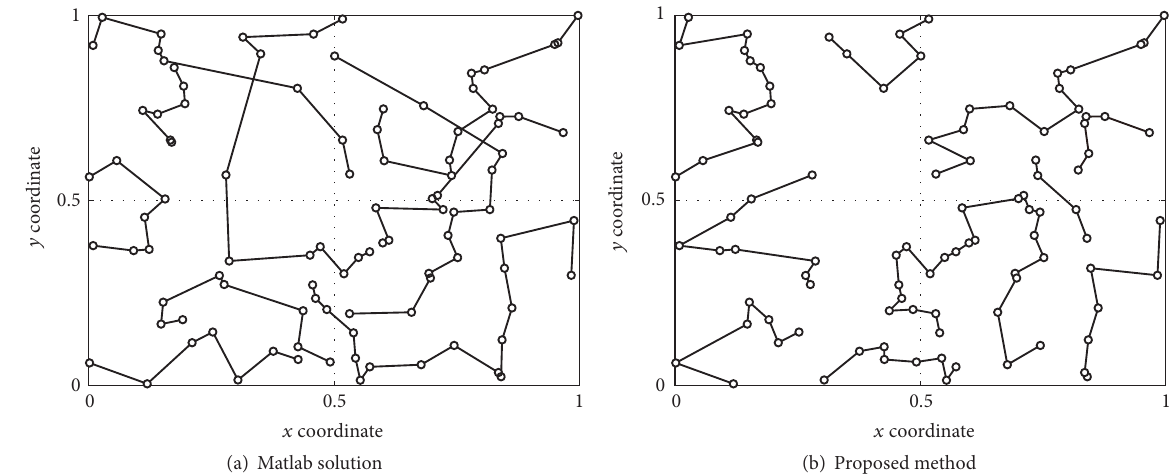
Figure 8: GAID has been compared with the Matlab MTSP solver. In this example, MAPP is solved for 100 targets randomly distributed in the unit square. 𝑚 = 10 agents are considered. The minimum path length is 𝑘 solution obtained by running the MTSP Matlab solver is shown, with cost 7.92 . In (b) our solution is shown with cost 6.37 , which is 19.5 % better than the Matlab MTSP